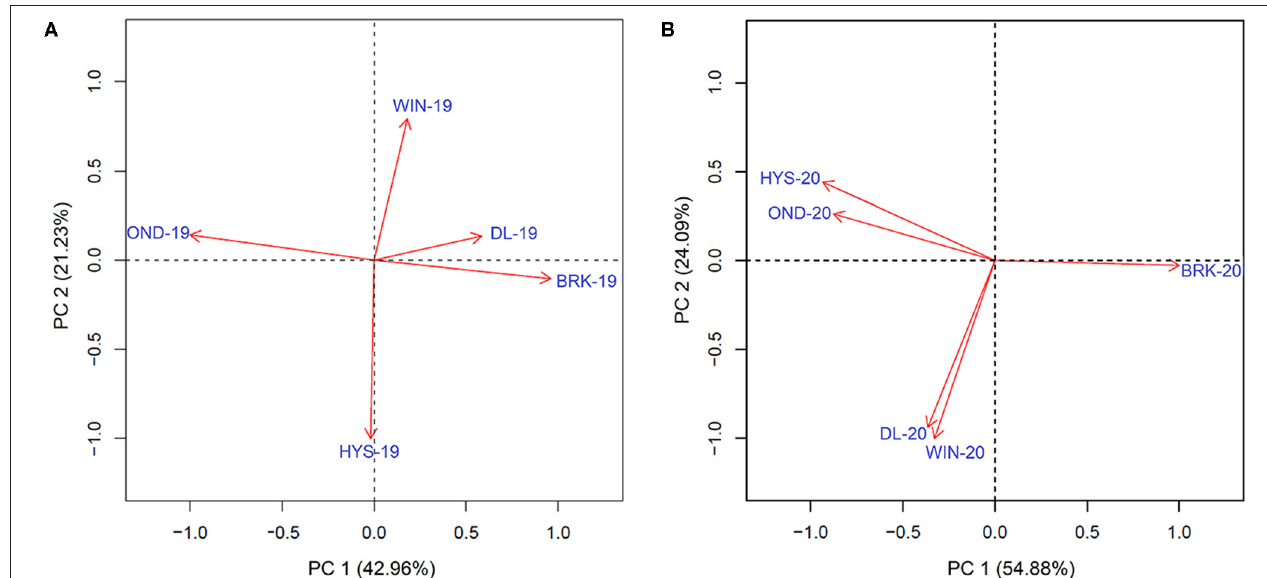
FIGURE 2 | Principal component analysis to determine the association of the observed grain yield among five different experimental sites in the (A) 2018–19 growing season and the (B) 2019–20 growing season. BRK, Brookings; DL, Dakota Lakes; HYS, Hayes; OND, Onida; and WIN,